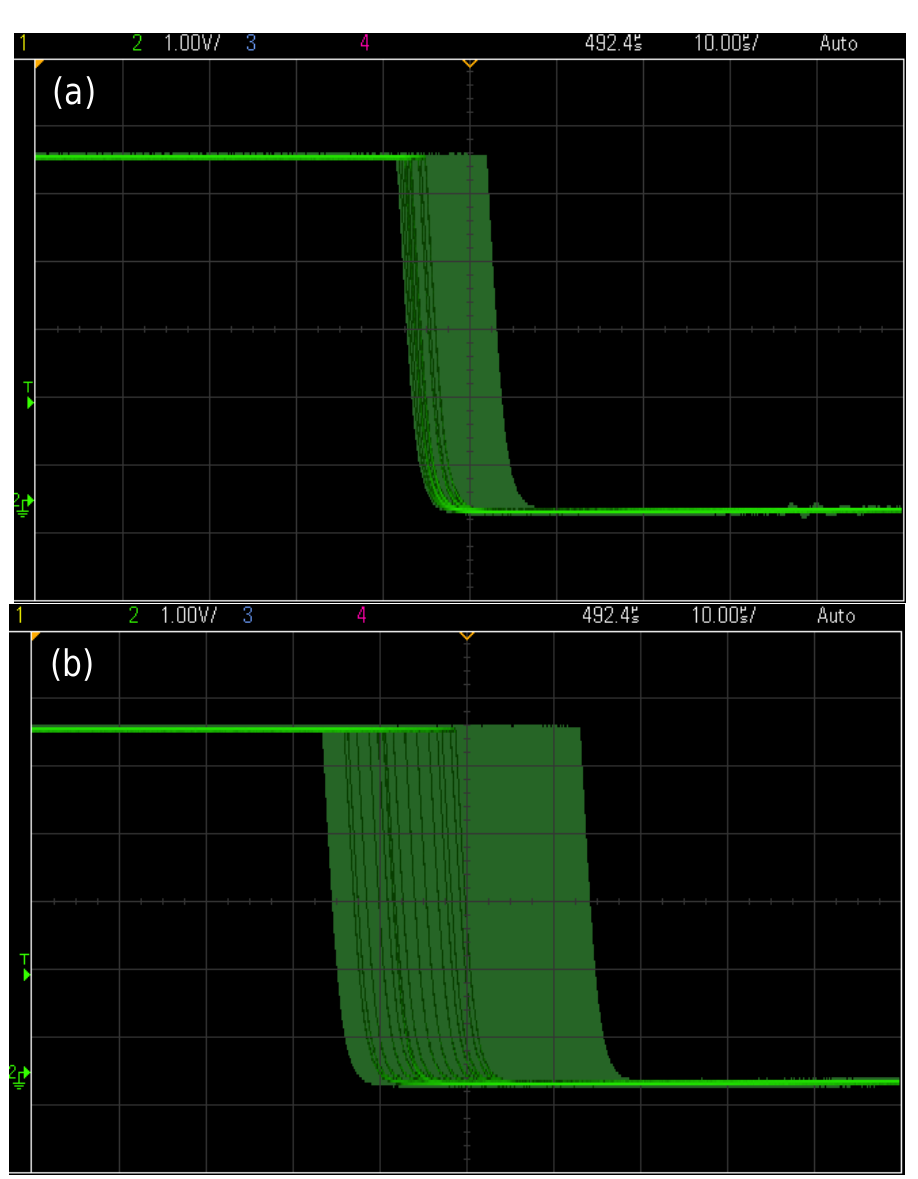
Figure 5. PWM signals in D for two distinct PZT strain amplitudes, ( a ) strain amplitude = 0.2 Vpp and ( b ) strain amplitude = 1.4 Vpp. The vertical axis is voltage (1V/div) and the horizontal axis is time (10 μs/div).